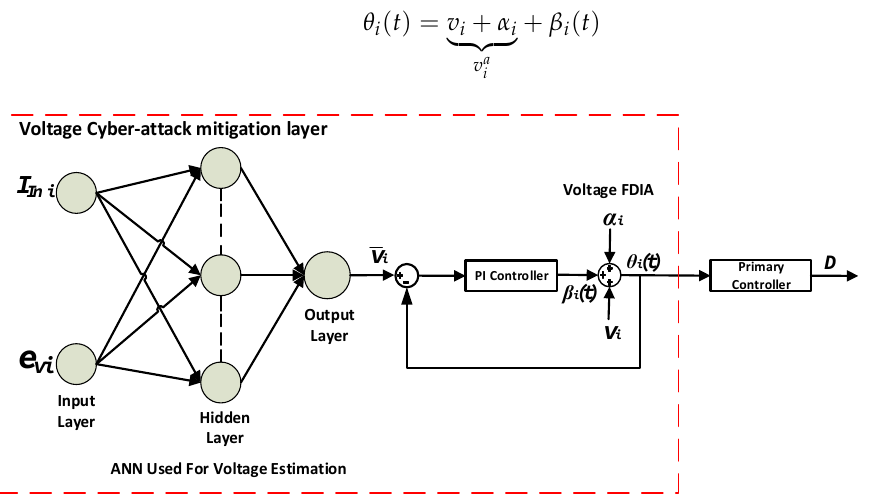
Figure 4. Voltage cyber-attack detection and mitigation layer proposed for the primary controller of DGU i.